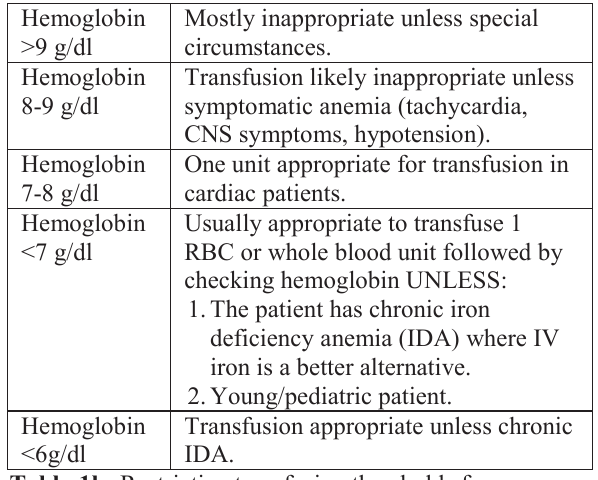
Table-1b: Restrictive transfusion thresholds for nonbleeding stable patients 17